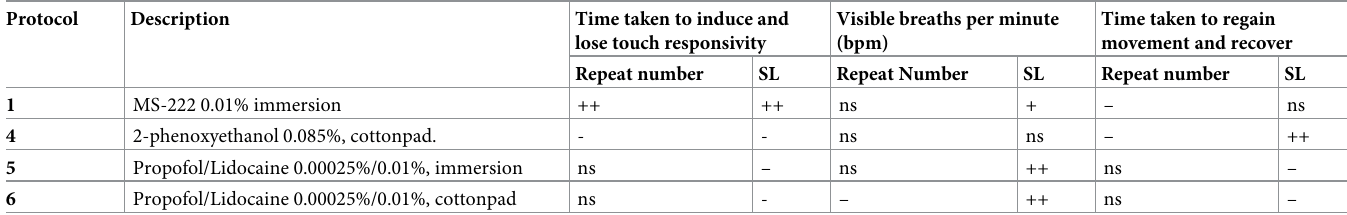
Results based on multiple linear regression models given in the supplementary material. Symbol ‘++’ indicates that the variable causes a significant positive effect and the effect is with a high magnitude i . e . > 5 (s or bpm) per repeat number or 5 (s or bpm) per SL. Symbol + indicates a positive effect that is significant, without fulfilling the criteria for ‘++’. ‘ns’ indicates that the variable is not significant. Symbol ‘–’ indicates that the variable causes a significant negative effect and the effect is with a